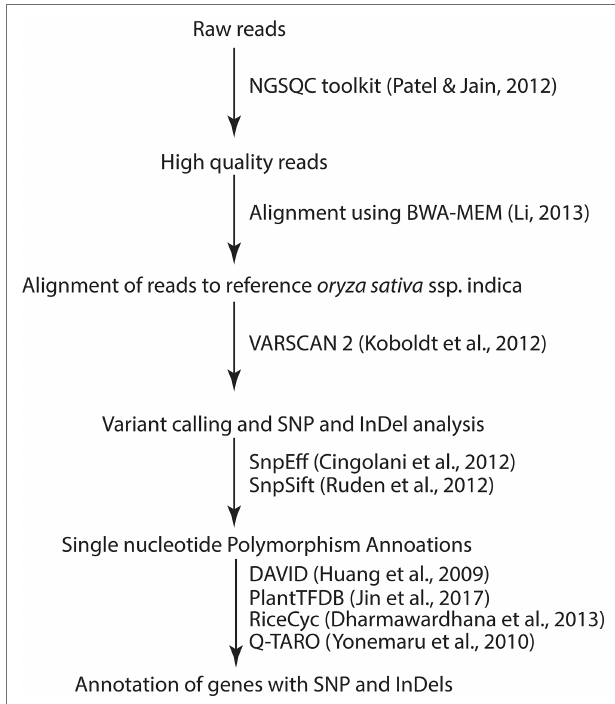
FIGURE 1 | Pipeline followed for the analysis of NGS data in this